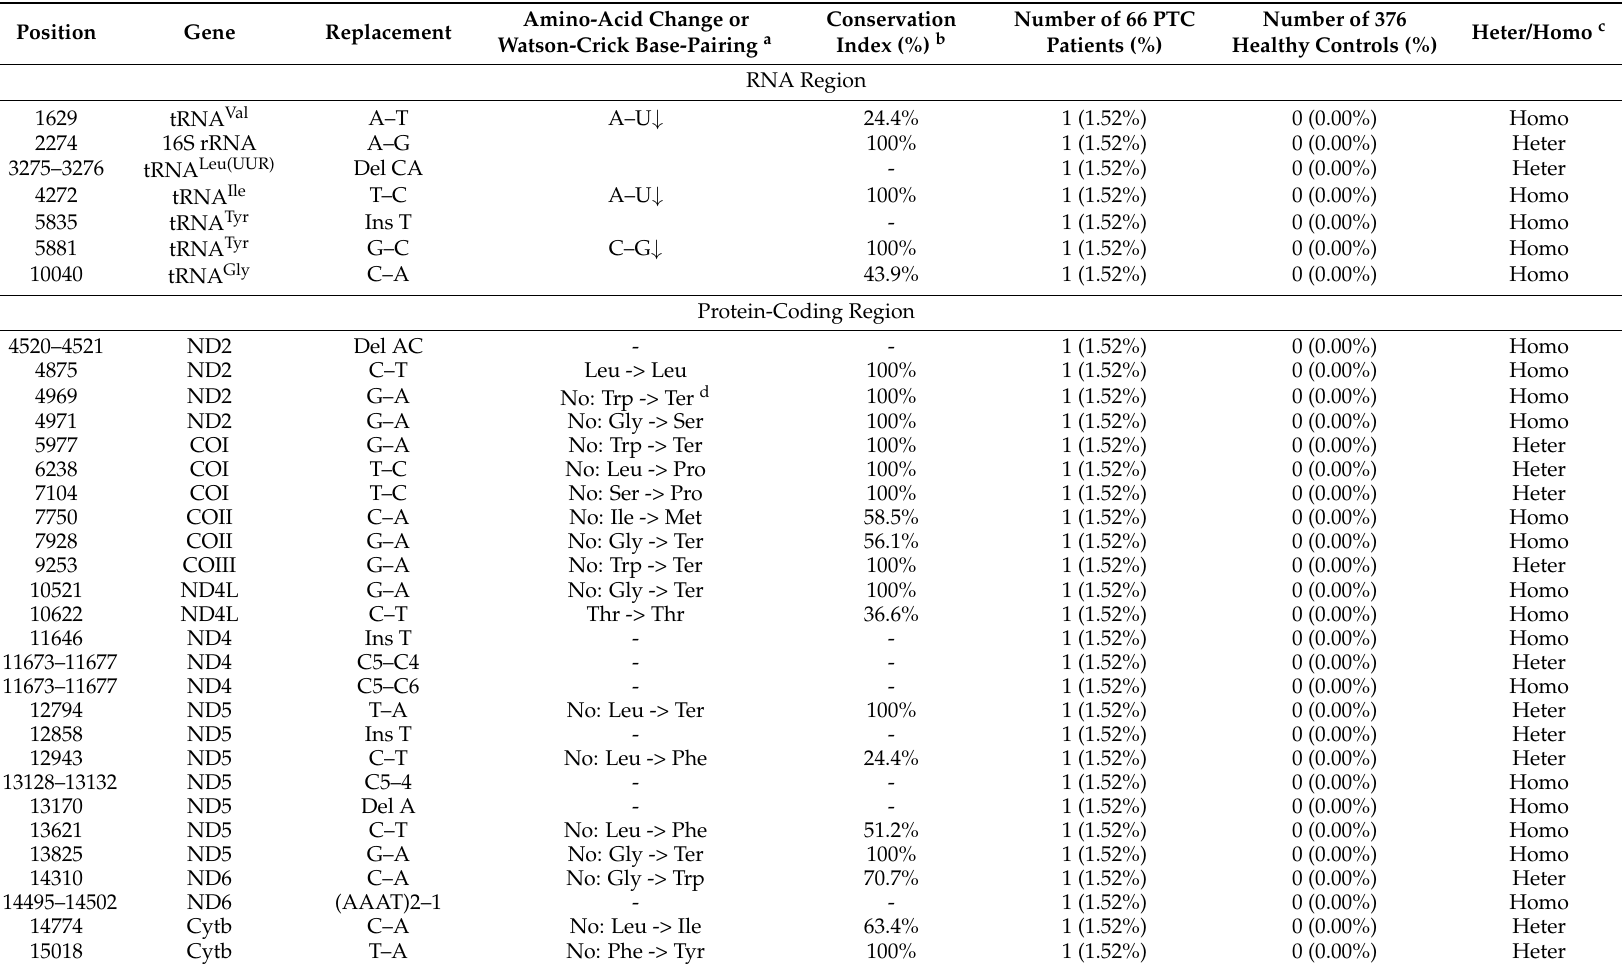
Table 1. Novel mtDNA variations in the entire mitochondrial